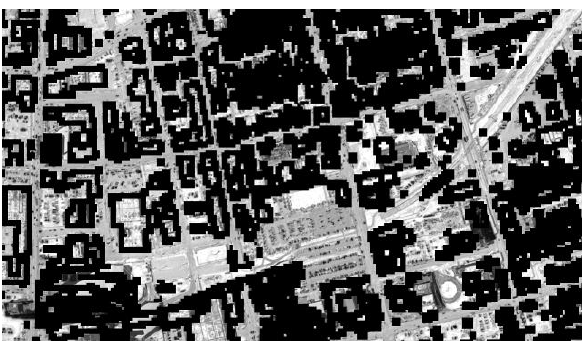
Figure 5. A constraint mask after adding breakline contributions